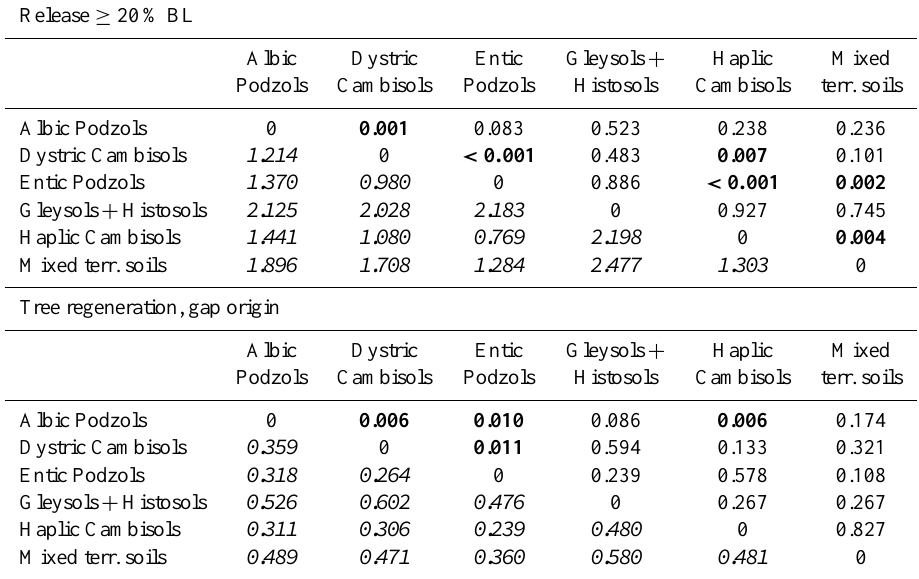
Table 2. Euclidean distances (under diagonal) between dendrochronological disturbance histories of forests on individual soil taxonomical units (STUs) and the statistical significance of their similarities (above diagonal, for details see Sect. 3.4.1 and Fig.